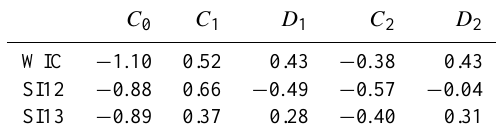
Table 4. Harmonic coefficients for correction of PALBs derived from IMAGE FUV images between May 2000 and August